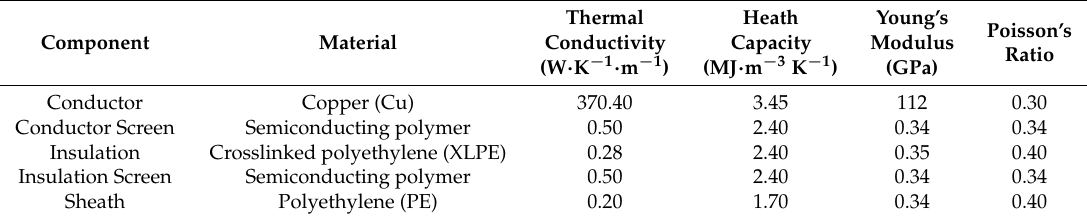
Table 2. True stress and plastic strain.